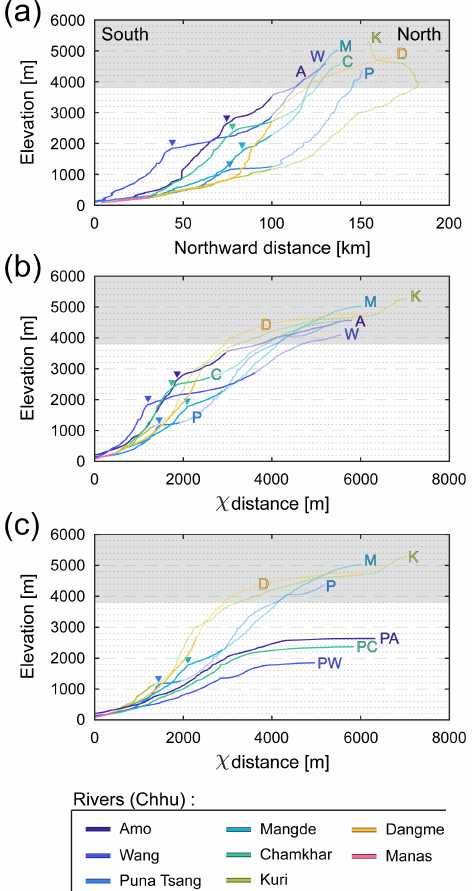
Figure 5. Projected and transformed profiles of major and large rivers in Bhutan. Rivers are located on the maps of Fig. 1, color- coded and labeled. Major knickpoints are also pointed by trian- gles. Regions with altitudes above 3800m (grey area) are not to be compared directly to the downstream sections as these may have a glacial imprint. Portions of the rivers north of physiographic tran- sition T3 are reported by transparent segments. (P)A: (proto-)Amo Chhu; (P)W: (proto-)Wang Chhu; P: Puna Tsang Chhu; M: Mangde Chhu; (P)C: (proto-)Chamkhar Chhu; K: Kuri Chhu; D: Dangme Chhu. (a) Longitudinal profiles projected along a north–south axis, structural directions (Fig. 1a). Except for the Wang Chhu, all